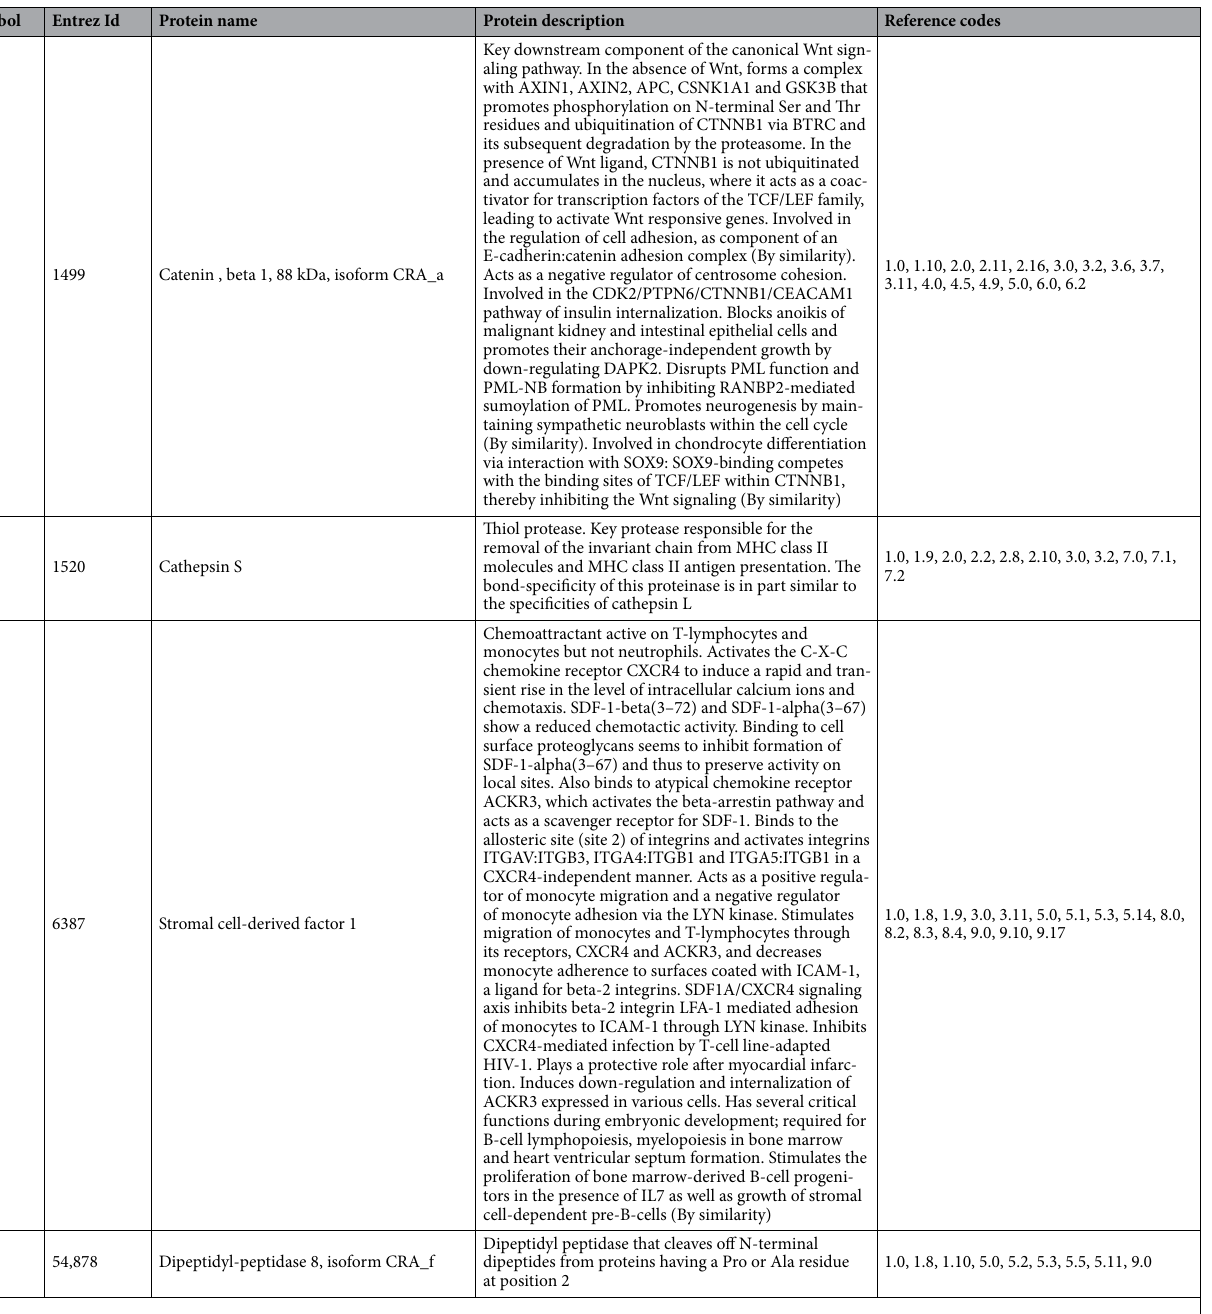
Dipeptidyl peptidase that cleaves off N-terminal dipeptides from proteins having a Pro or Ala residue at position